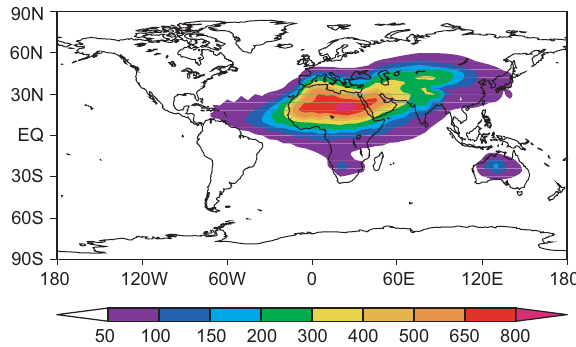
Fig. 2. Annual mean column burden of dust aerosol simulated in the control experiment with fixed SST (FIXSST_CTRL). Unit: mg m -2 .